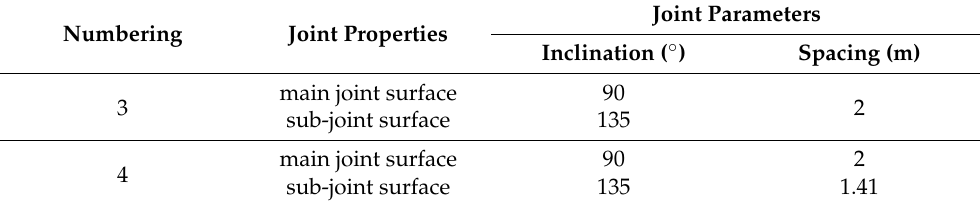
Figure 9. Development of joint and instability form the coal wall rib-spalling ( α = 60°). Figure 10. Development of joint and instability form the coal wall rib-spalling ( α = 90°, non-through seam).